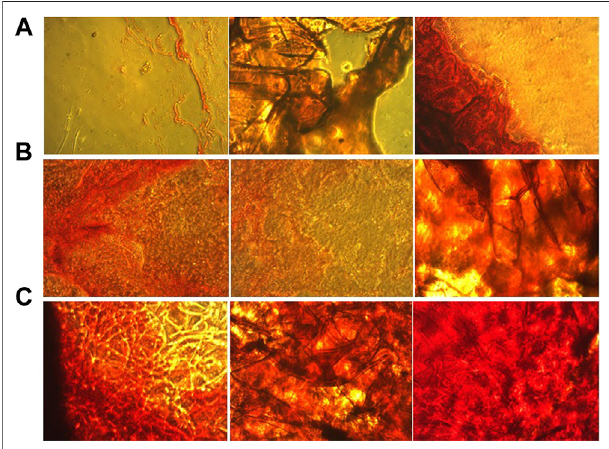
FIGURE8| Alizarinred stainingofculturehASCsonthe (A) Gel, (B) Gel- HNT and (C) Gel-HNT/ZA Scaffolds at 7, 14 and 21 days.